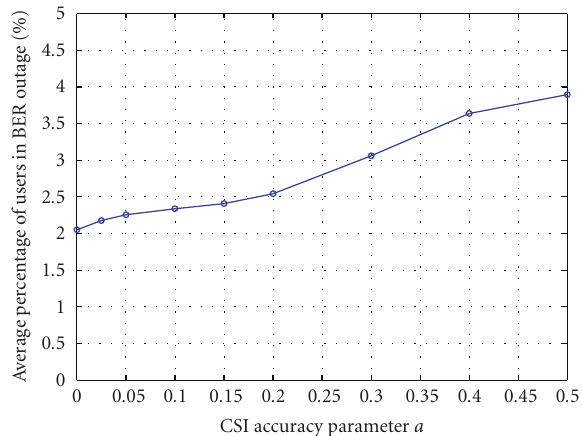
Figure 14: E ff ect of CSI accuracy measured by the parameter a on the average percentage of users in BER outage ( U = U max , P tot =